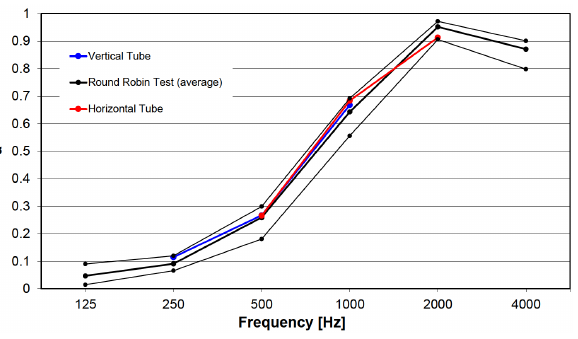
Figure 4: Comparison between experimental data obtained from the current setup and the RRT. The thin black lines represent the maximum and minimum values obtained for each frequency in the RRT Table 1: Percentage of open area ( σ ) and Transparency Index (TI) for the different metal plates used as perforated facing